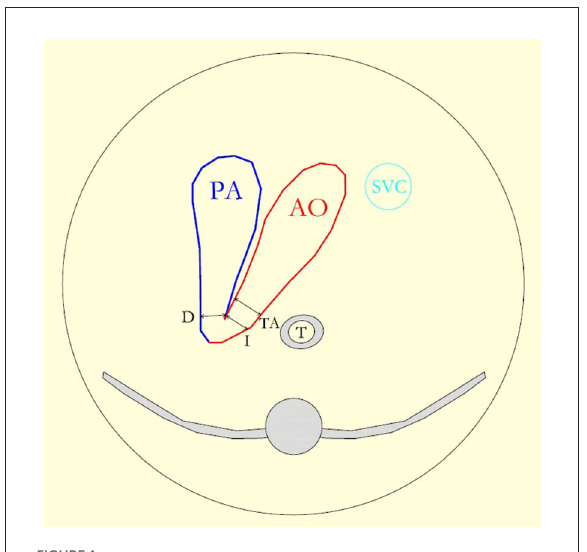
FIGURE1 The diagram reproduces the three vessel and the tracheal view and shows the pulmonary artery (PA) leading into the arterial duct (D), the aortic arch (AO), and the superior vena cava (SVC). The lines show the measurement of, respectively, the isthmus (I), the duct, and the distal transverse aortic arch (TA)